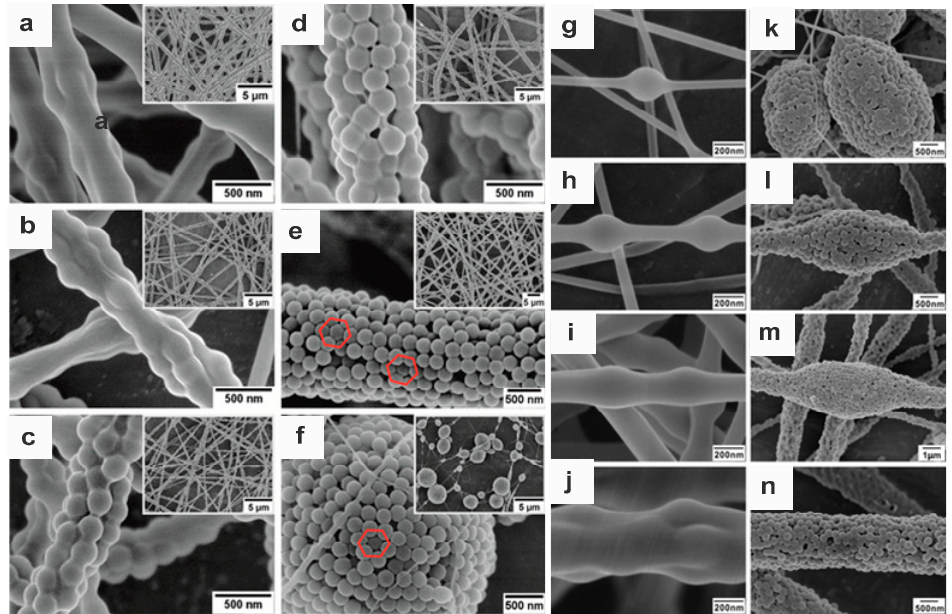
Figure 7. SEM graphs of polystyrene nanoparticles into PVA nanofibres: ( a – f ) different weight ratios of PS and PVA of 1:4, 1:2, 1:1, 2:1, 4:1 and 6:1; The inserted images in each subfigure from a to f are measured under lower magnification. ( g – n ) different concentrations of PVA: 7, 9, 11, 13 wt%, while ( g – j ) PS:PVA is 1:4 and ( k – n ) PS:PVA is 4:1. Reprinted with permission from [12] American Chemical